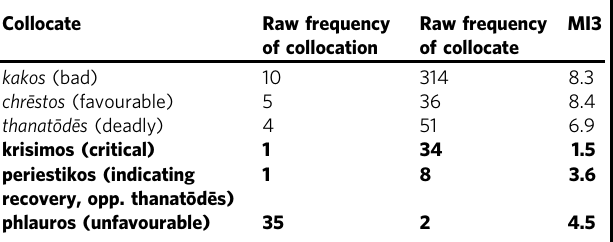
See Table 4 for collocation parameters; metric id: ENG ADJ.